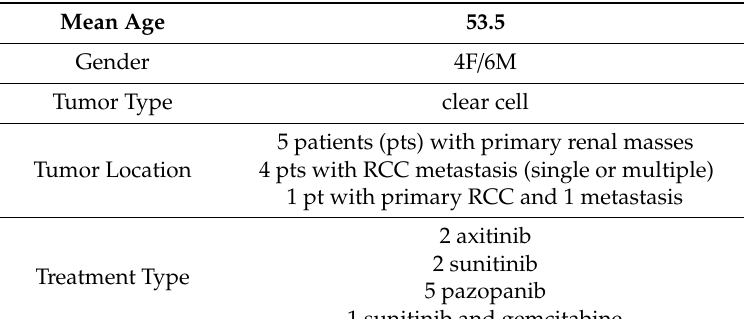
Table 1. Patient Demographics, tumor type and